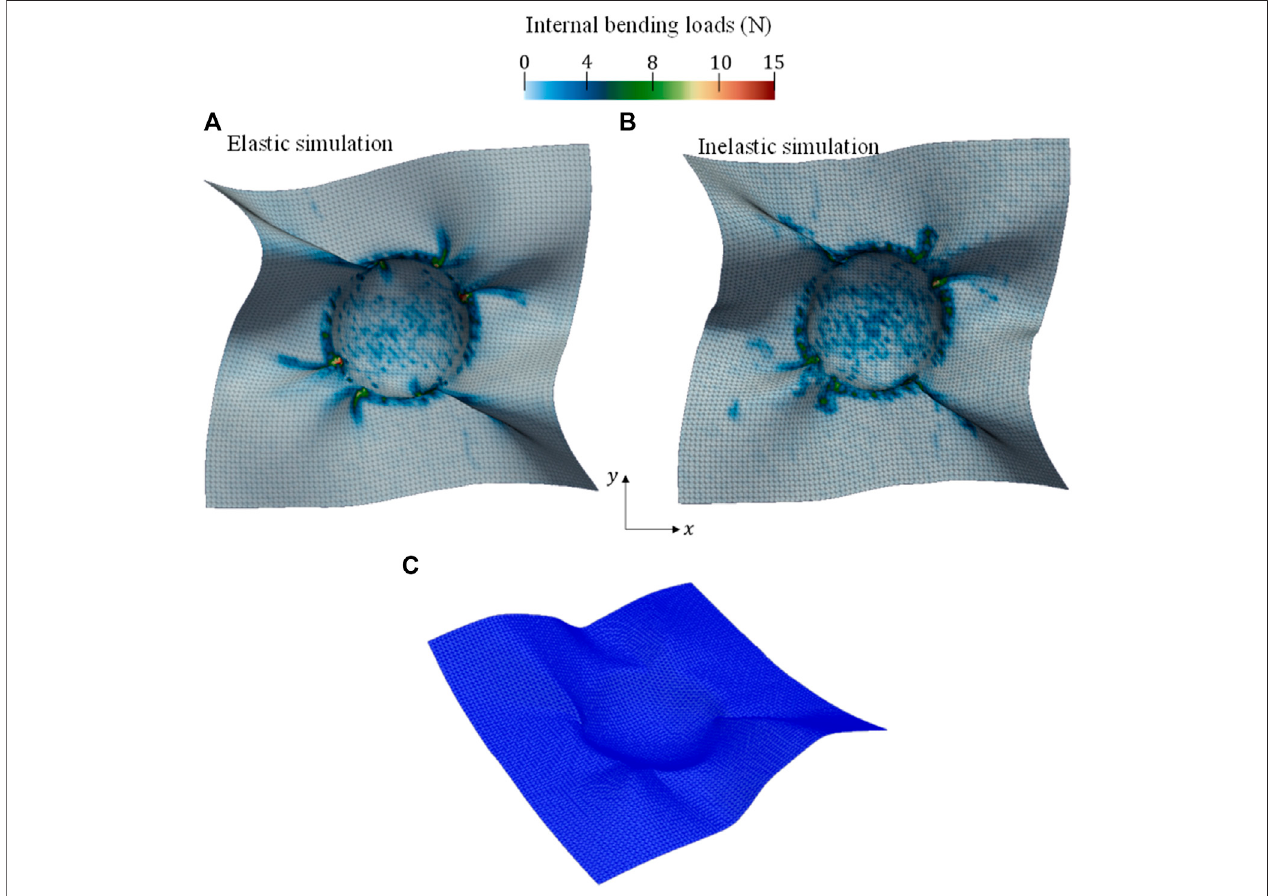
FIGURE 15 | Internal bending loads (A) elastic simulation, (B) inelastic simulation. (C) Numerical geometry of the reinforcement after the removal of the hemispherical punch (inelastic simulation) (Colored version